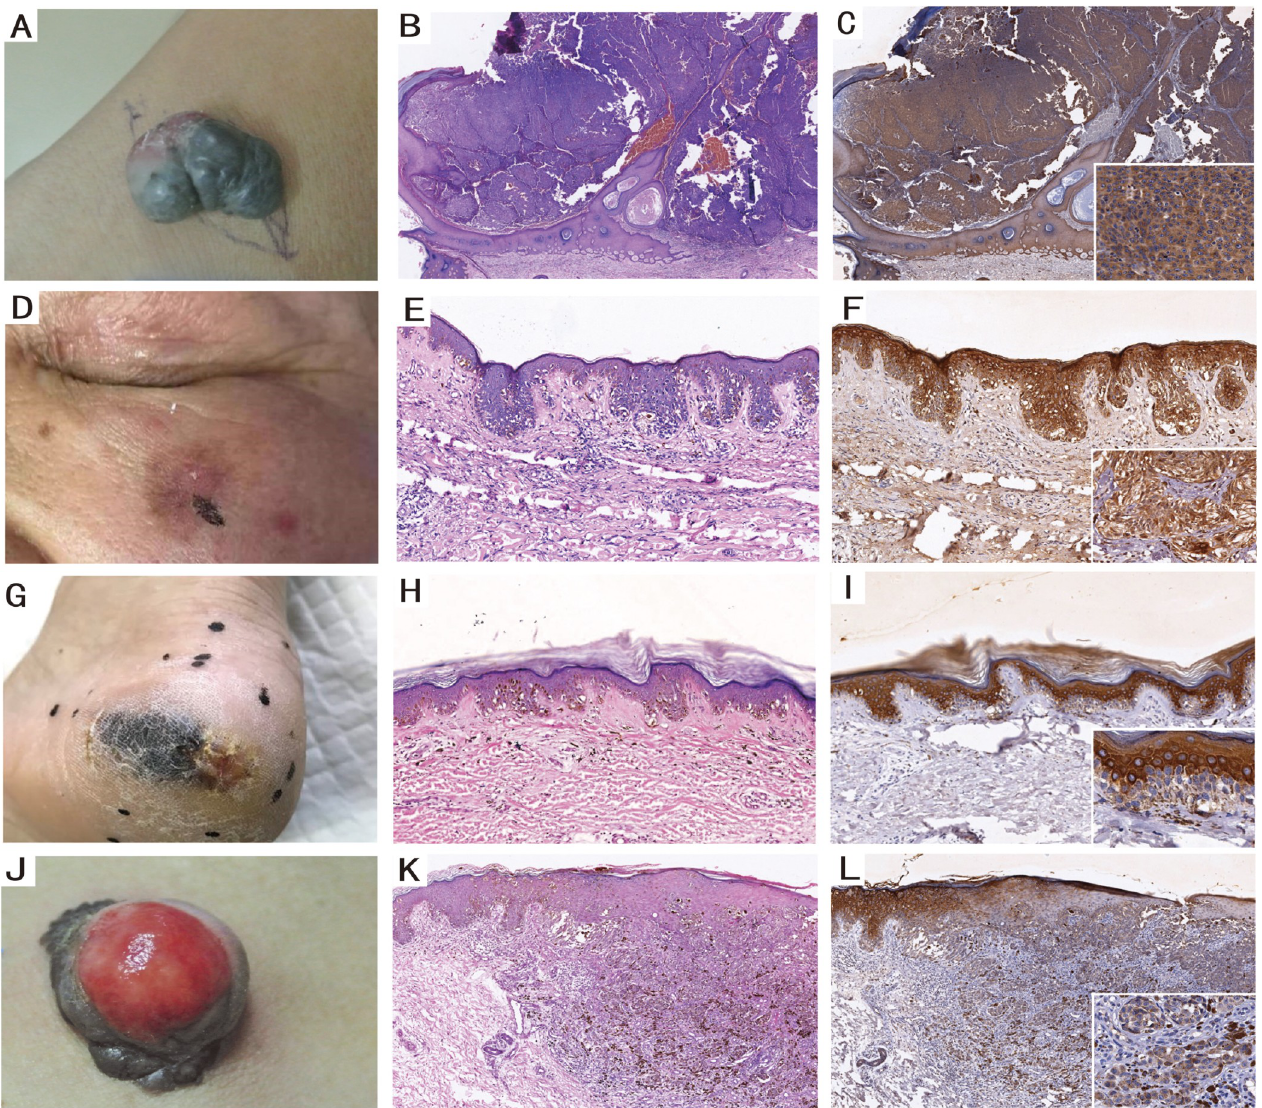
Fig 4. HSP105 expression in different pathological classification. (A) Clinical and (B; HE × 10) histopathological picture of the NM located in wrist. (D) Clinical and (E; HE × 100) histopathological picture of the LMM located in face. (G) Clinical and (H; HE × 100) histopathological picture of the ALM located in foot. (J) Clinical and (K; HE × 100) histopathological picture of the SSM located in thigh. HSP105 showed intense staining in (C; IHC × 10) NM and (F; IHC × 100) LMM, but it showed weaker staining in (I; IHC × 100) ALM and (L; IHC × 100) SSM.